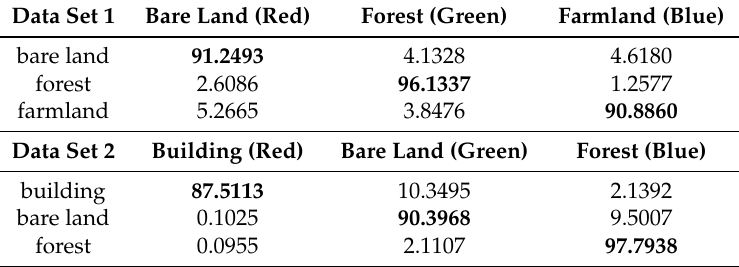
Figure 6. ( a – u ) From top to bottom are the shared label truth of each data set and the results on the first date of each data set. From left to right are the shared label truth and the results of coherent feature classification, incoherent feature classification, co-training, Simple MKL, PCA and the proposed method respectively. Table 3. Confusion matrix of the results achieved by the proposed method on the first date of data set 1 and data set 2.